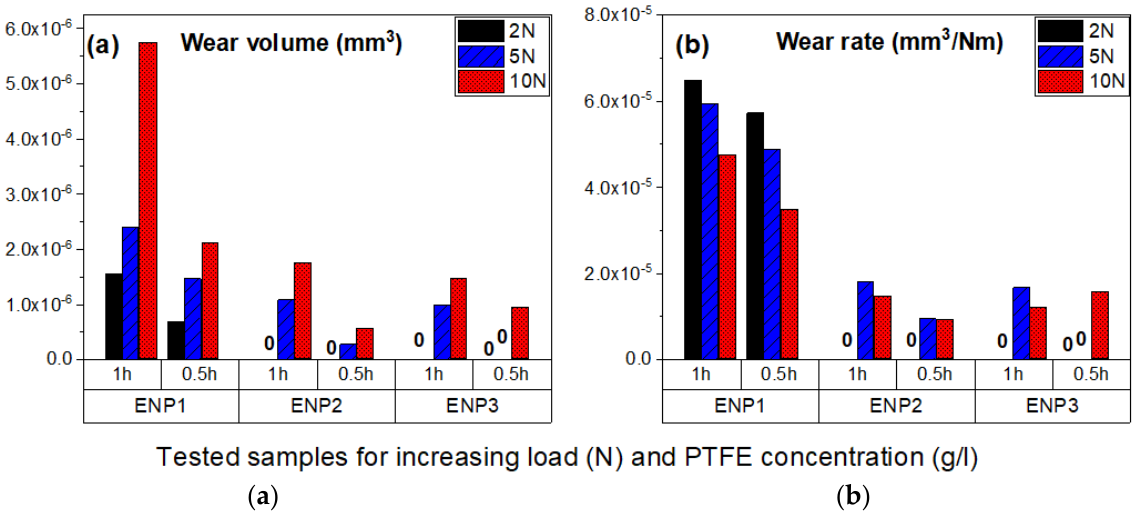
Figure 8. Volume loss from worn tracks ( a ) and wear rates ( b ) of the deposited electroless ENP+PTFE: ENP1, ENP2 and ENP3 duplex coatings at the different loads.